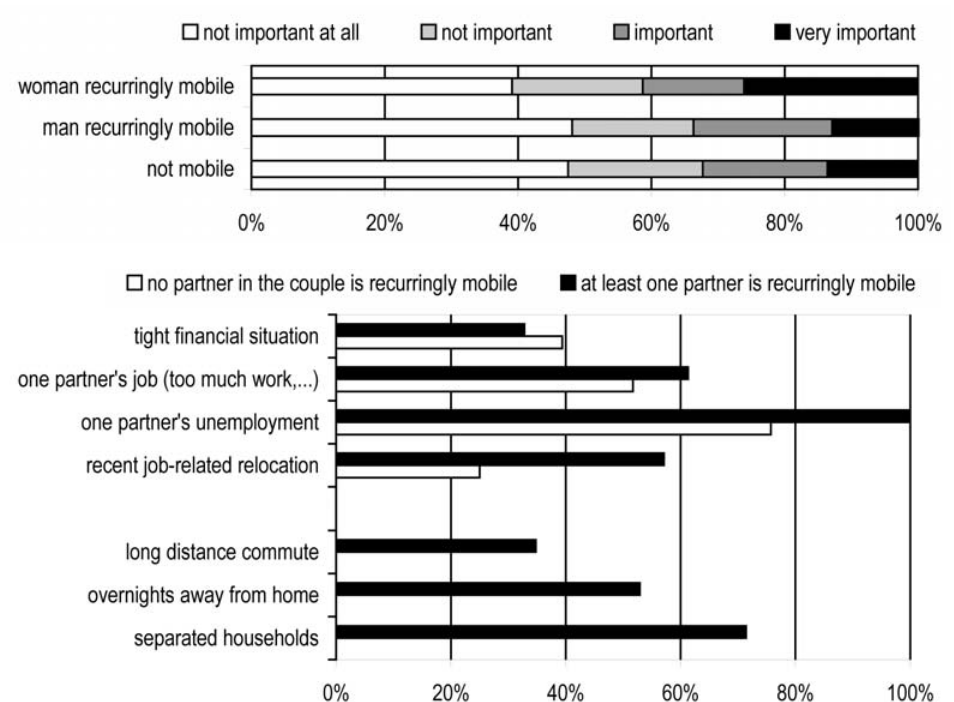
Figure 3 : Subjective evaluation of the reasons for